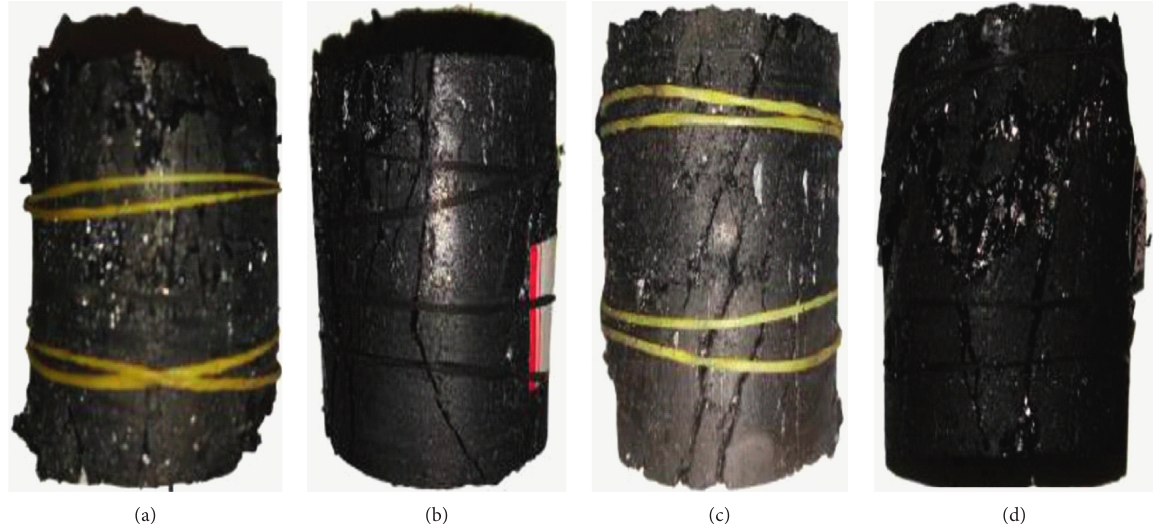
Figure 13: Failure morphology of coal samples at different cycle stages: (a) first cycle step, (b) second cycle step, (c) third cycle step, and (d) final